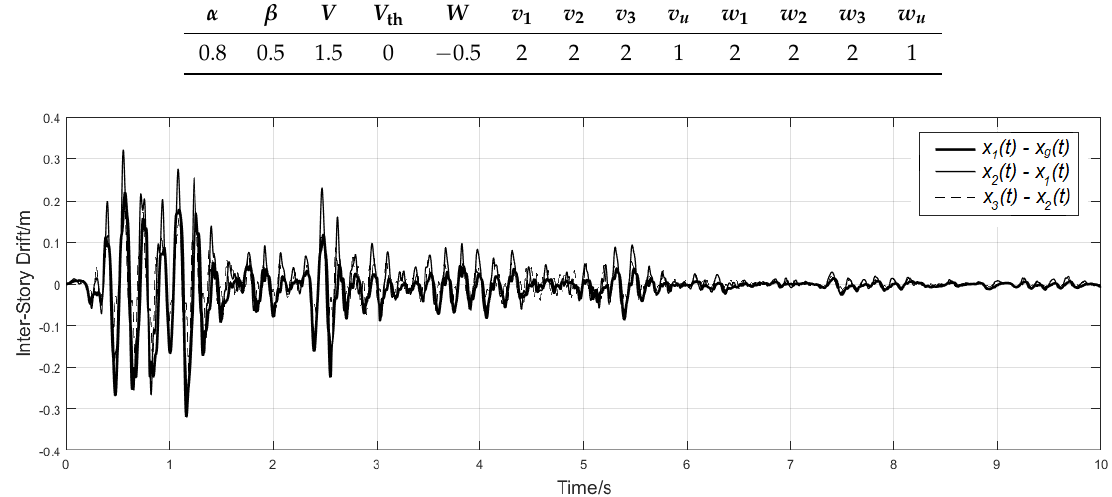
Table 2. BELBIC controller parameters empirically estimated.